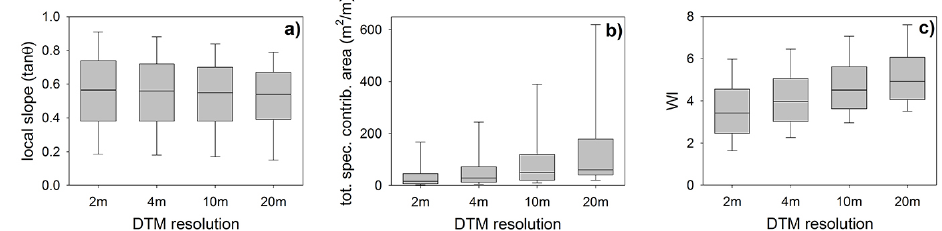
Figure 4. Box plots of topographic attributes for the four different DTM resolutions: (a) local slope, (b) total specific contributing area, (c) WI. The boxes show the 25th and 75th percentile, the whiskers show the 10th and 90th percentile, the horizontal line within the box indicates the median.